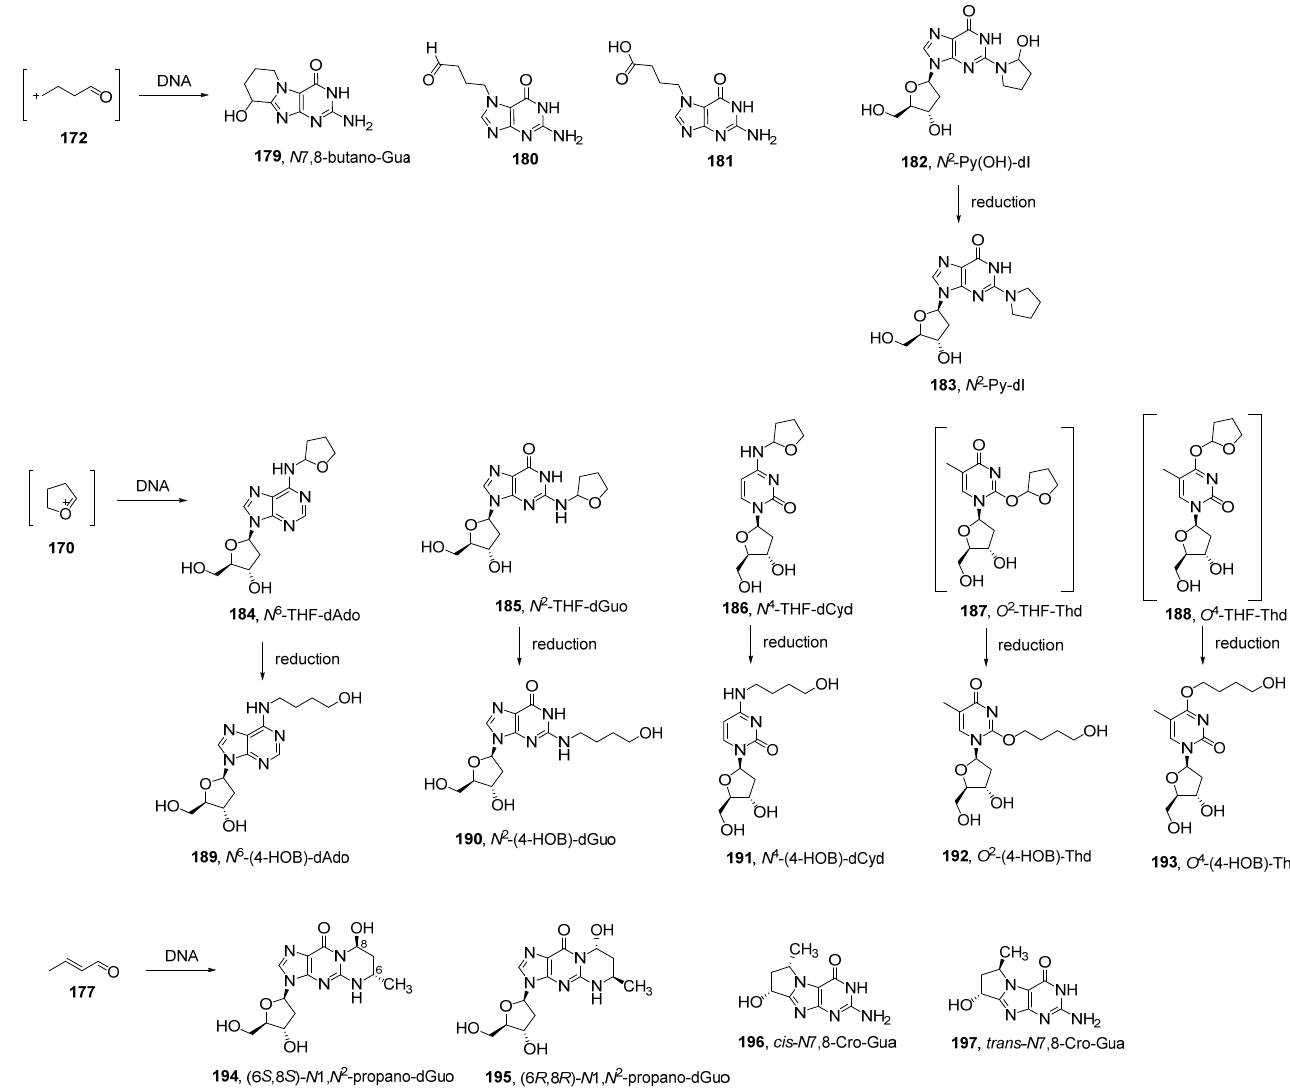
Figure 12. Structures of DNA adducts formed by NPYR metabolism.